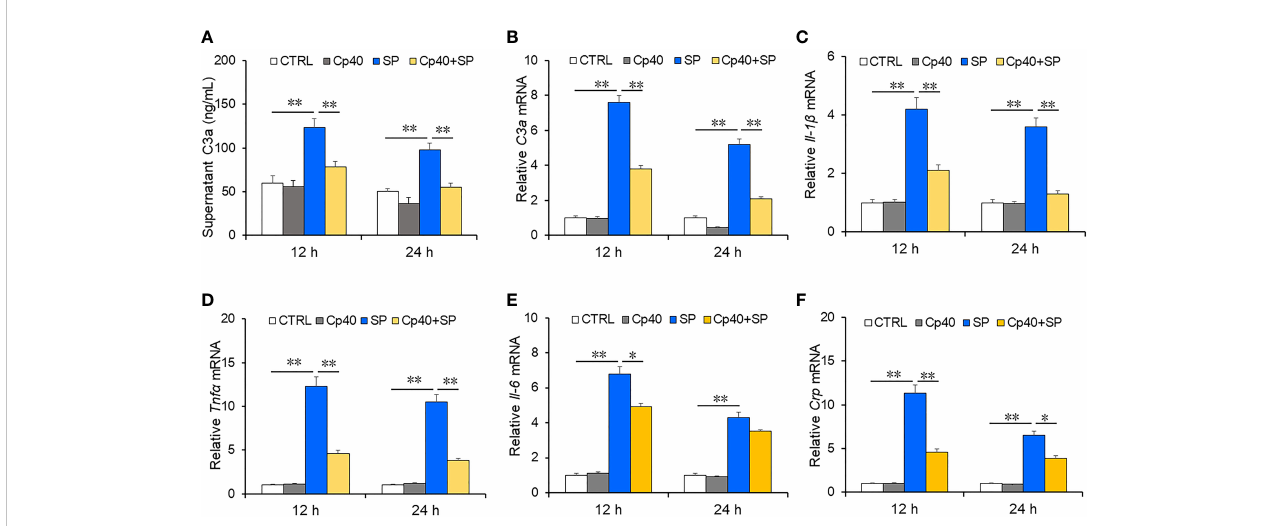
FIGURE 3 The levels of complement C3a and in fl ammatory cytokines in MLE-12 cells after SP infection. In the Cp40 and Cp40+SP groups, MLE-12 cells were pre- incubated with Cp40 (200 µM) at 24 h and 48 h before SP exposure. Then, MLE-12 cells were exposed with SP (10 7 CFU/ml) in SP and Cp40+SP groups. In the control group, MLE-12 cells were co-cultured with DMSO. Lastly, supernatant and cells were collected at 12 h and 24 h after SP exposure. The expressions of C3a and in fl ammatory cytokines were measured in MLE-12 cells. (A) The level of supernatant complement C3a was measured at 12 and 24 h after SP injection in MLE-12 cells through ELISA. (A) C3a. (B) The level of complement C3a mRNA was measured through RT-PCR at 12 and 24 h after SP infection in MLE-12 cells. (B) C3a mRNA. (C – F) The levels of in fl ammatory cytokine mRNAs were measured through RT-PCR at 12 and 24 h after SP injection in MLE-12 cells. (C) IL-1 b mRNA; (D) TNF- a mRNA; (E) IL-6 mRNA; (F) Crp mRNA. All data were expressed as mean ± SEM of six samples ( n = 6). The statistical difference was analyzed by ANOVA method. * p < 0.05, ** p < 0.01.